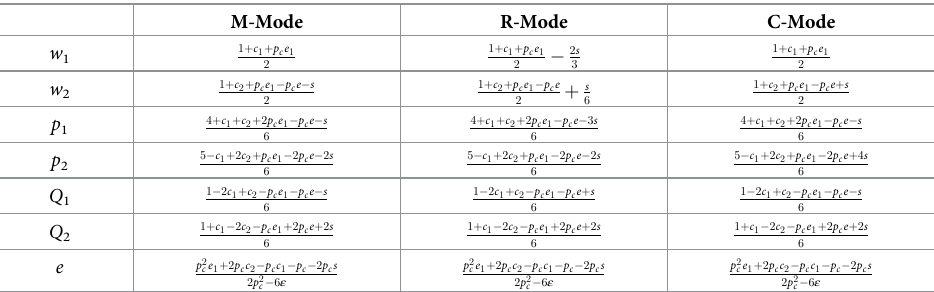
Table 2. Equilibrium